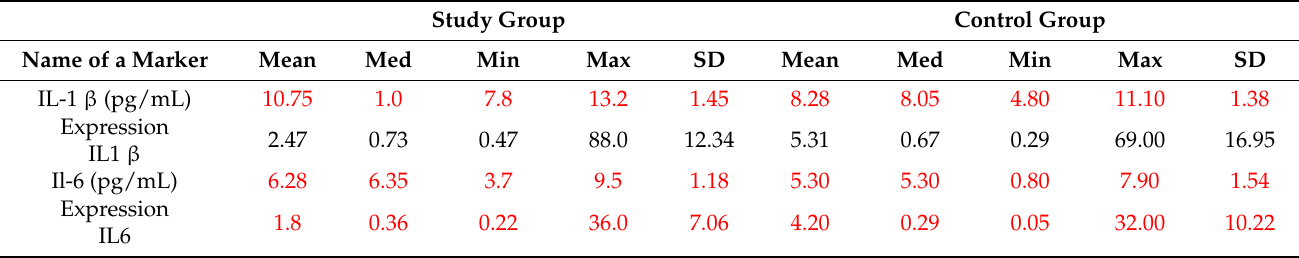
Table 3. Inflammatory markers in the study group, the control group and comparison between them (statistically significant results marked with red